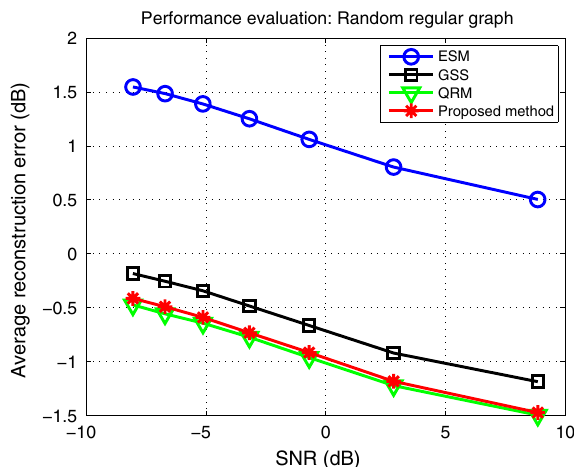
Fig. 8 Performance evaluation for noisy non‑bandlimited graph signals on RRG with | S | = 50 by varying SNR